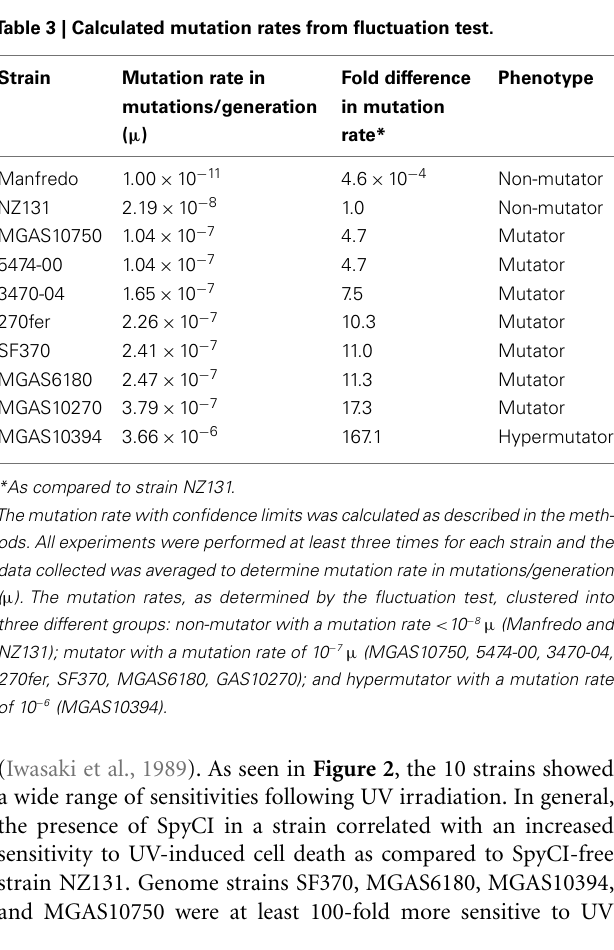
FIGURE 2 | Mutation rate and UV sensitivity of S. pyogenes strains. The grouping of the S. pyogenes strains by mutation rate ( µ ) is shown as in Table 3 . Next to the calculated mutation rate, the sensitivity to UV irradiation